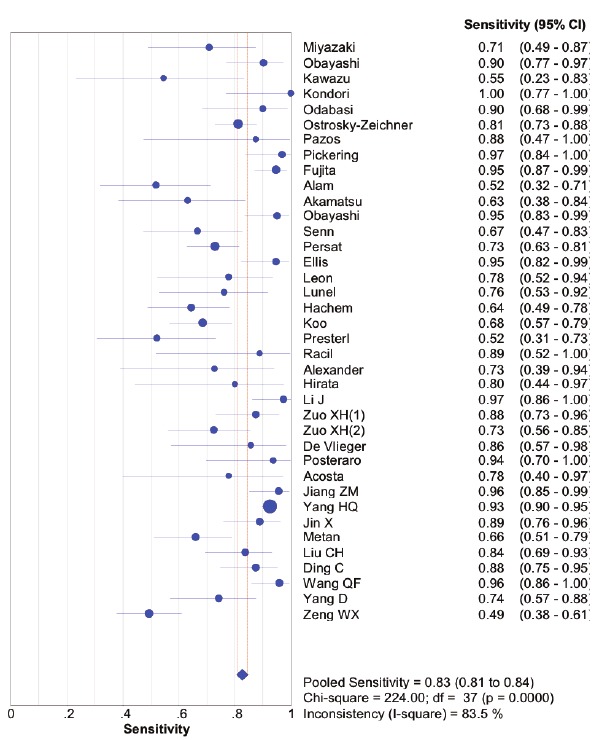
Figure 3: Pooled forest plot of sensitivity of 1,3-β-D-glucan in diag- nosis of invasive fungal